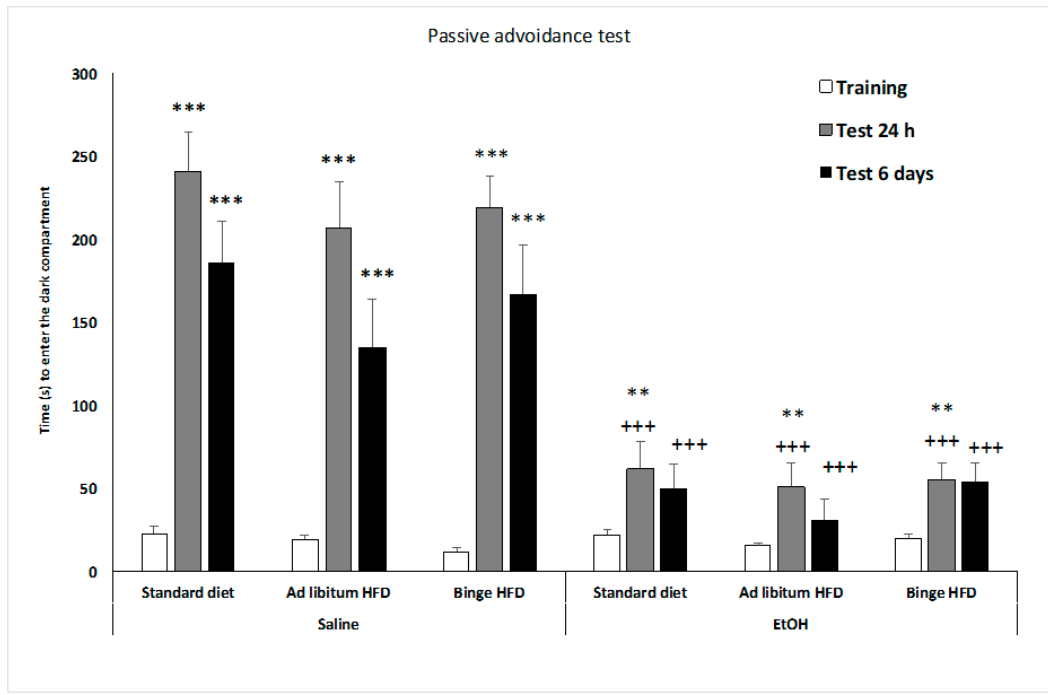
Figure 3. E ff ect of an ad libitum or binge high-fat diet exposure and EtOH binge on adolescent mice in the passive avoidance test. Bars represent the time taken to enter into the dark compartment in the training and test sessions (24 h and 6 days after training). Data are presented as mean ( ± SEM), ** p < 0.01, *** p < 0.001 versus training session; +++ p < 0.001 versus saline counterparts.